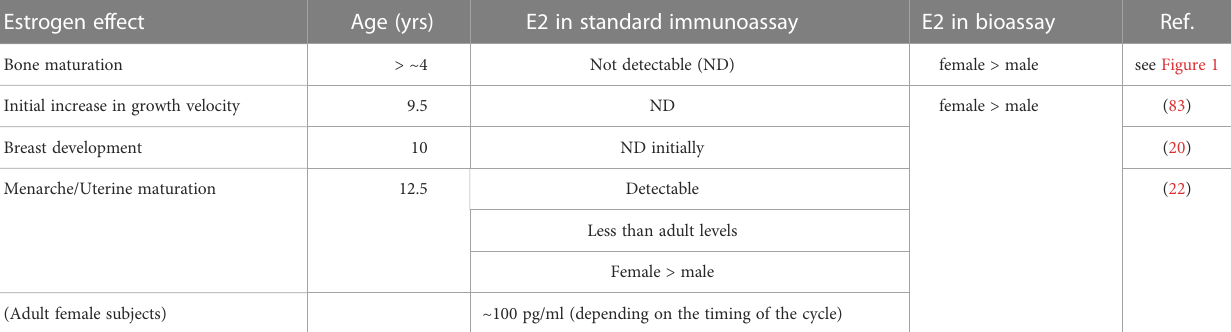
TABLE 5 Estimated serum estradiol levels and estrogen effects in female children.